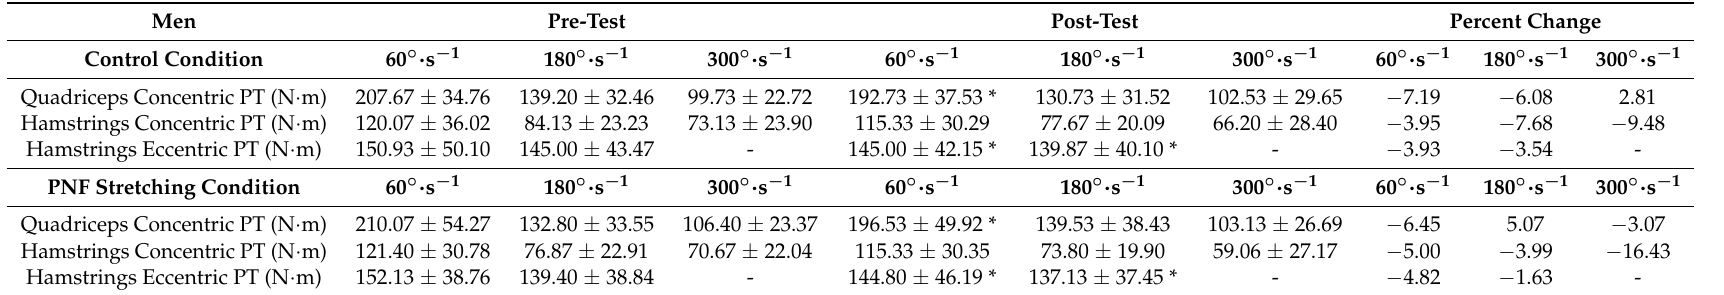
Table 1. Mean values ± SD of quadriceps and hamstrings concentric PT, and hamstrings eccentric PT for men.